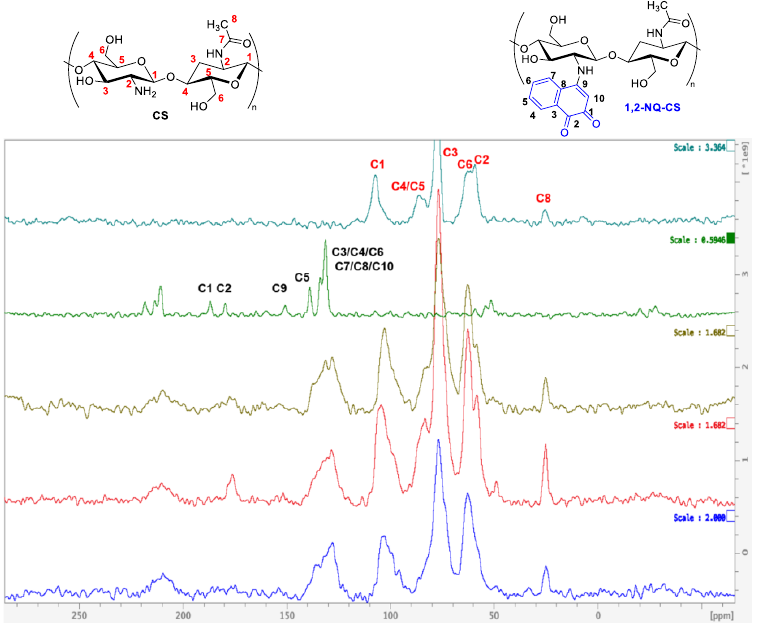
Figure 11. 13 C Solid State CP/MAS-10KHz NMR (125 MHz) spectra of chitosan (light green), 1,2-NQ (green), 1,2-NQ-CS obtained by method a (brown), 1,2-NQ-CS obtained by method b (red) and 1,2-NQ-CS obtained by method c (blue).